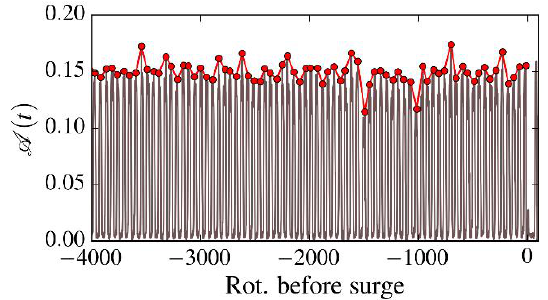
Figure 9. Evolution of the maximum of the unsteady alternate rate during throttling ramp operation .